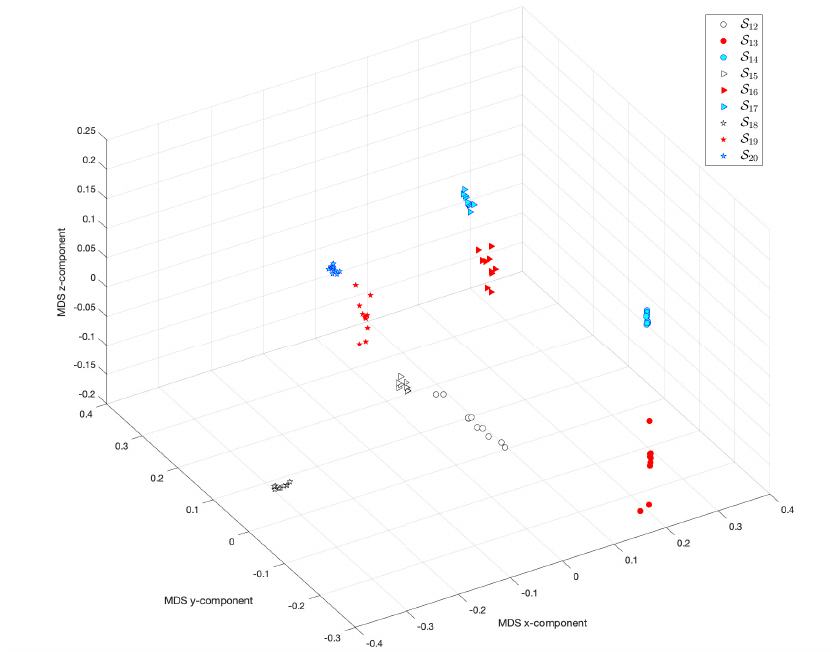
Figure 21. The 3-dimensional MDS locus, using the Canberra distance (5), for 10 runs of each scenario S = 12, . . . ,20, with performance captured by the cost indices I i , i